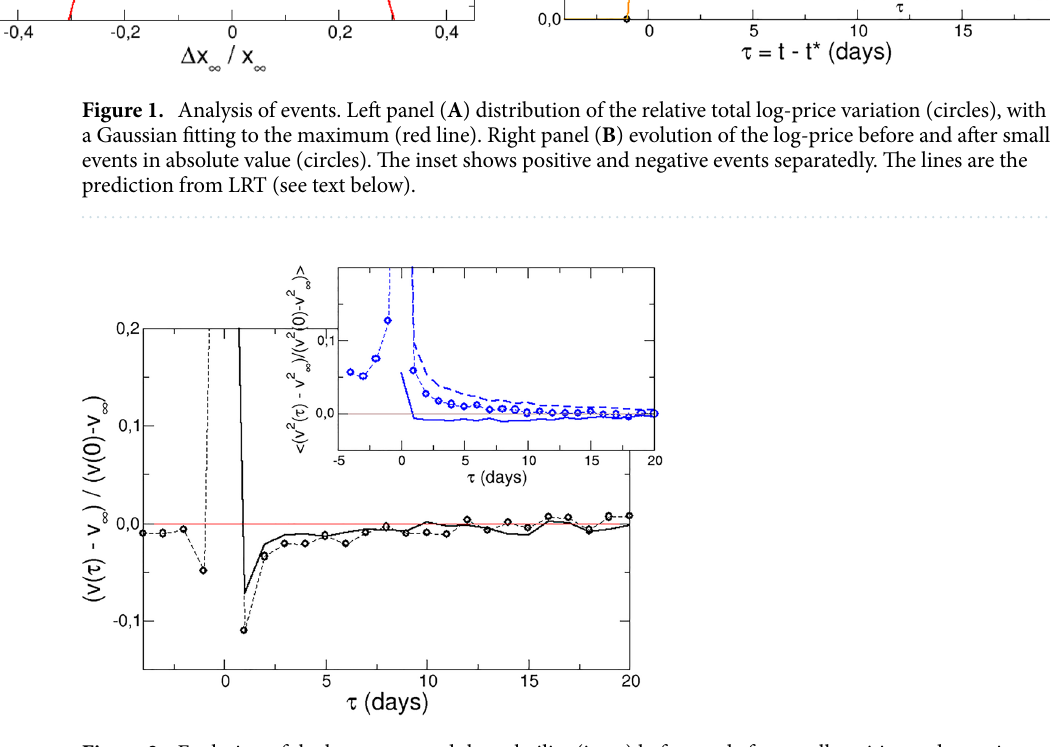
Figure 2. Evolution of the log-return and the volatility (inset) before and after small positive and negative events. The lines show the prediction of linear response theory (see text